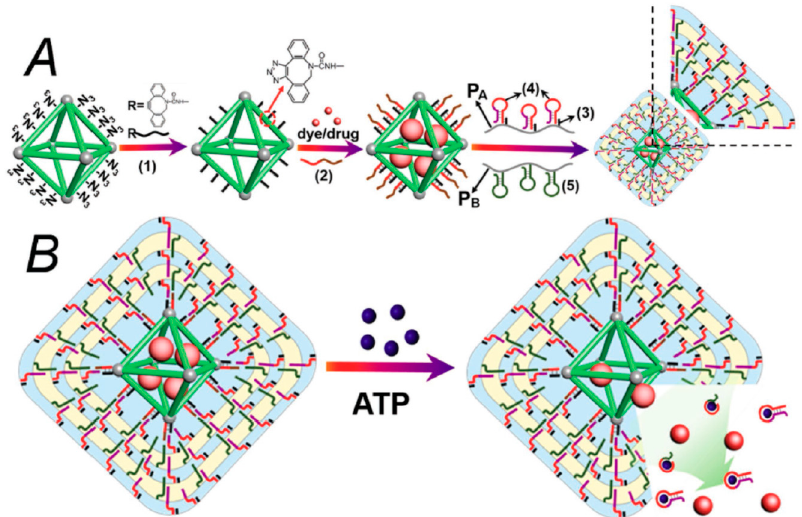
Figure 16. ( A ) Synthesis of ATP-responsive DNA/polyacrylamide-hydrogel-coated NMOFs loaded with a fluorescence dye or doxorubicin. ( B ) Schematic mechanism to unlock the hydrogel-coated NMOFs and to release the load via the formation of ATP–aptamer complexes. Adopted from Chen et al. [23] with the permission of Wiley-VCH.